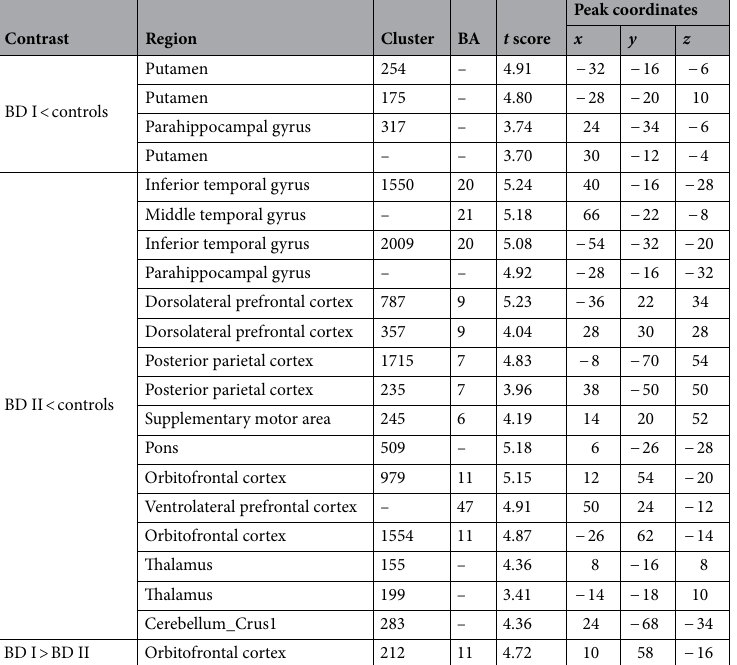
Table 3. Peak MNI coordinates for the regions exhibiting significant resting-state functional connectivity with the left dorsal caudate, with between-group differences. Peak coordinates refer to the Montreal Neurological Institute (MNI) space. BA Brodmann area, BD bipolar disorder. Significance was thresholded at the uncorrected voxel level p = 0.001, followed by the FWE-corrected cluster level p =